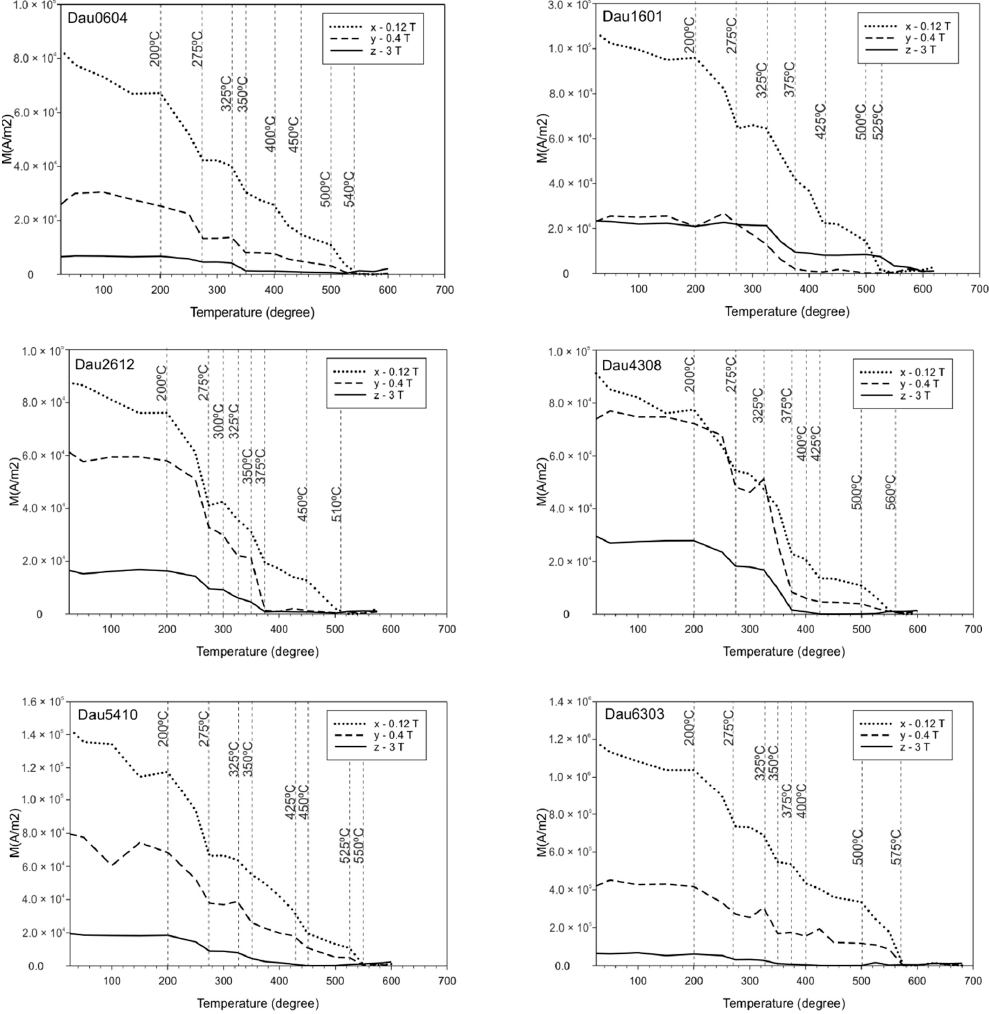
Figure 9. Results of three component IRM acquisition curve experiments [28] of the metadolerites of SW Oscar II Land.